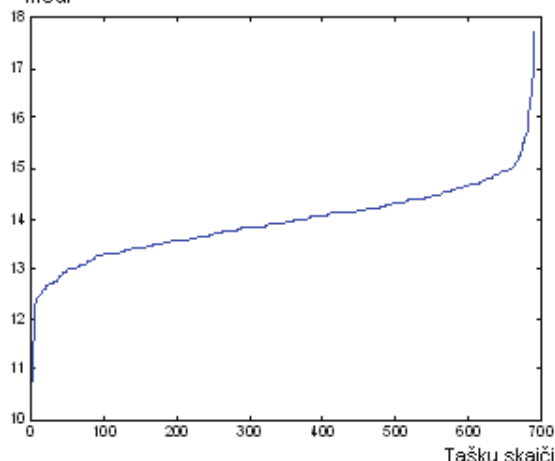
Fig. 1. Change of the differences between the measured and detected from the gravimetric map gravity accelerations, mGal Taikant gravimetriniuose punktuose apskaičiuotas